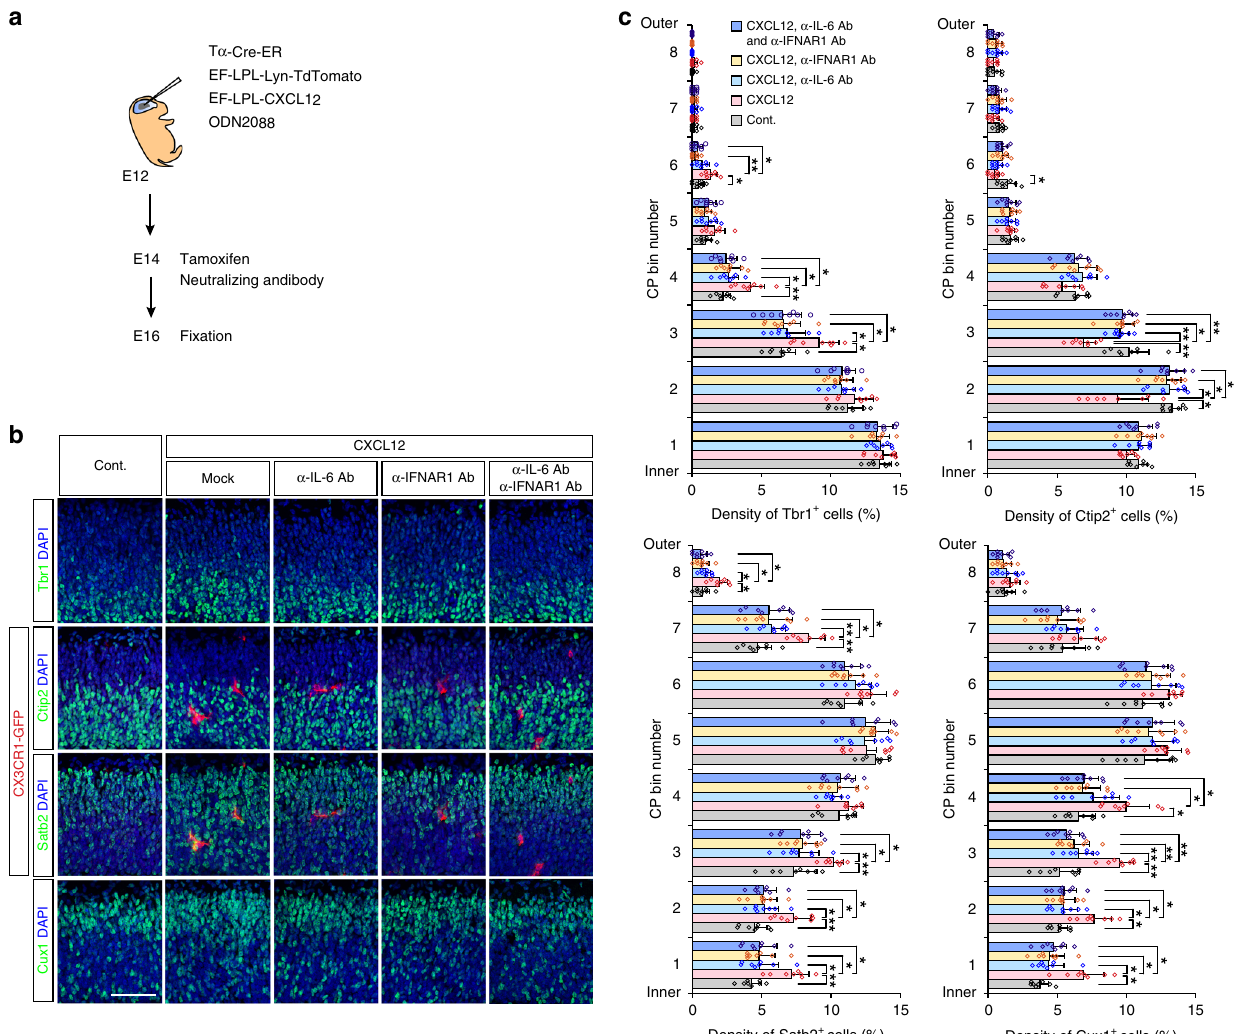
Fig. 10 In vivo administration of anti-IL-6 and/or IFNAR1 antibodies signi fi cantly attenuated the disturbed expression of neuronal subtype-associated transcription factors in postmigratory neurons. a The experimental design for the administration of neutralizing antibodies, which is combined with in vivo CXCL12 overexpression in postmigratory neurons. b Representative immunostaining (shown in pseudo color) for GFP (CX3CR1; red), Tbr1/Ctip2/ Satb2/Cux1 (green), and DAPI (blue) in control and CXCL12-overexpressing brains that were mock-treated or administered neutralizing antibodies for IL-6 or IFNAR1. Scale bar, 50 µ m. c The density of cells expressing Ctip2, Satb2, Cux1, or Tbr1 per total (DAPI + ) cells in 20 µ m bins in the CP, which was divided into eight zones (two-sided Steel – Dwass test; n = 8 sections from four mice; ** P < 0.01, * P < 0.05). Data are presented as the mean values ± S.D. The exact P values are summarized in Supplementary Table 1. Source data are provided as a Source Data